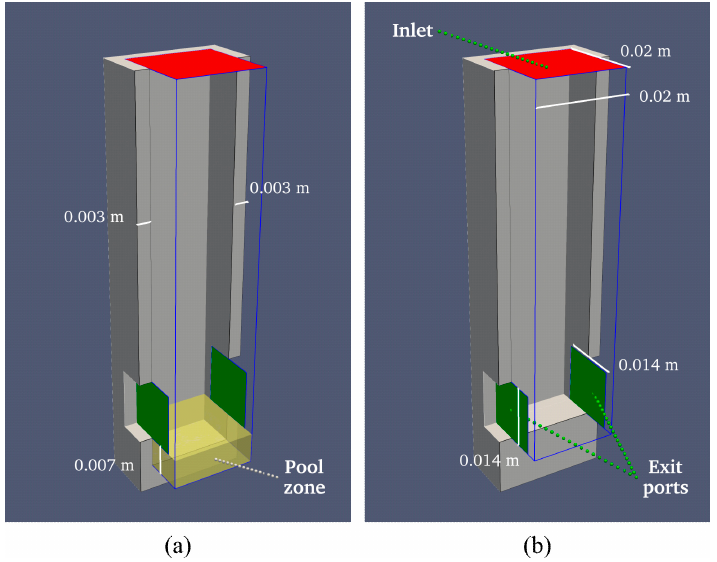
Figure 1. Geometry of the models studied in this work: ( a ) Nozzle with a bottom well, type A Nozzle Internal Prototype (NIP) and ( b ) Nozzle without a bottom well, type B NIP.